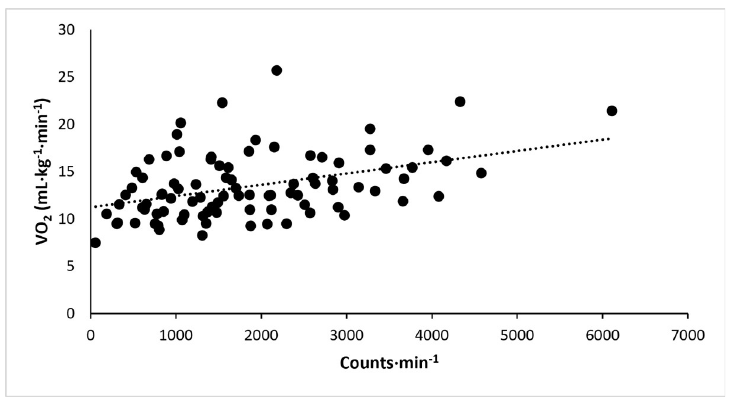
Fig 1. Scatter plot with a line of best fit for the relationship between activity counts and energy expenditure in 30 persons with PD.